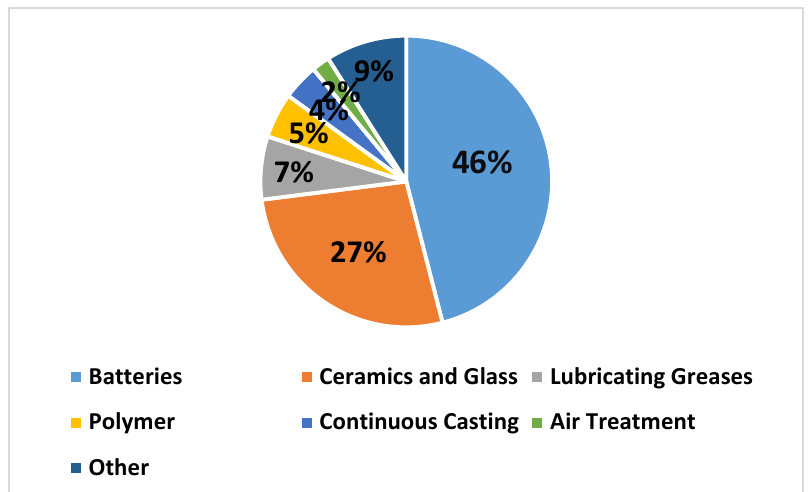
Figure 2. Diagram of lithium usage proportions [19] .